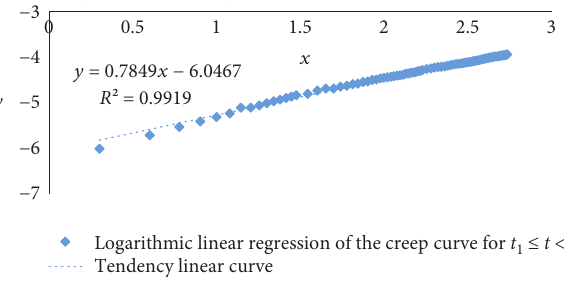
Figure 8: Logarithmic linear regression curve of creep in the ≤ t ≤ t interval t 1 2